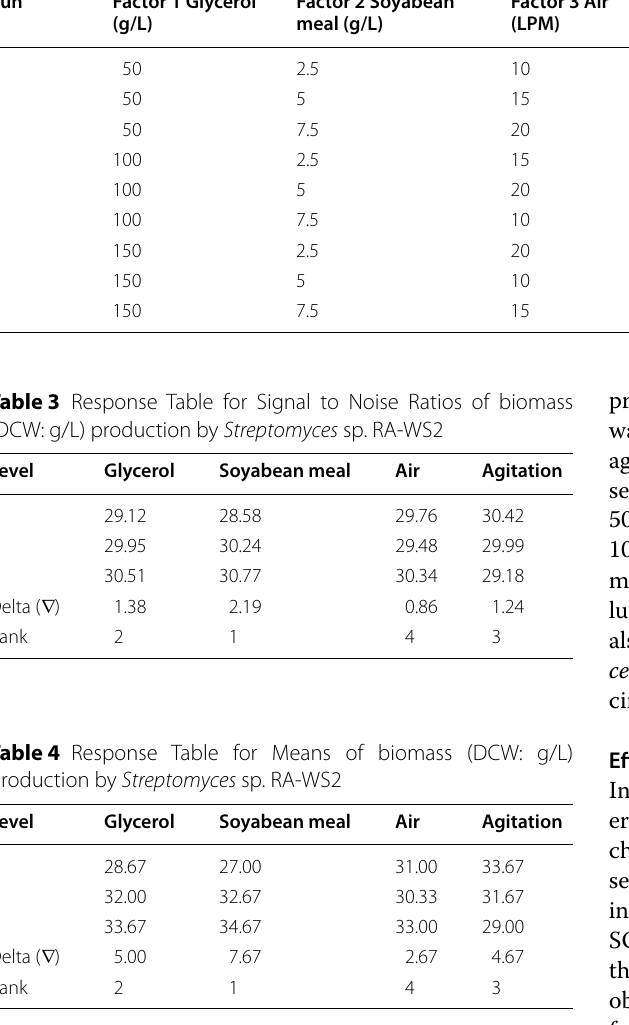
Table 2 Response table of the orthogonal array design L9 for biomass (DCW) and setomimycin production by Streptomyces sp. RA-WS2 Run